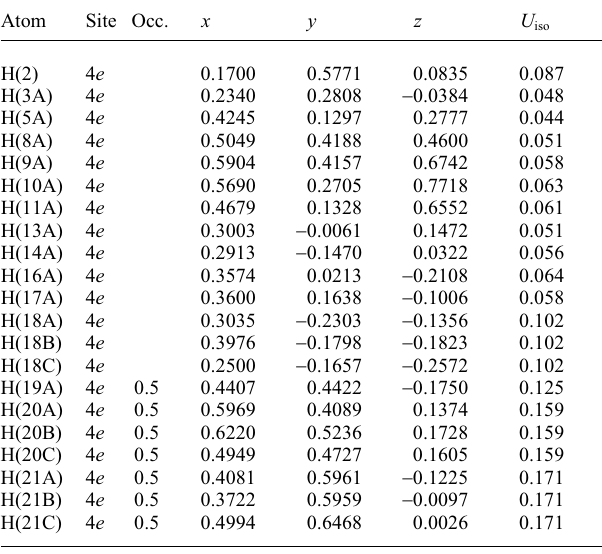
Table 2. Atomic coordinates and displacement parameters (in Å 2 )